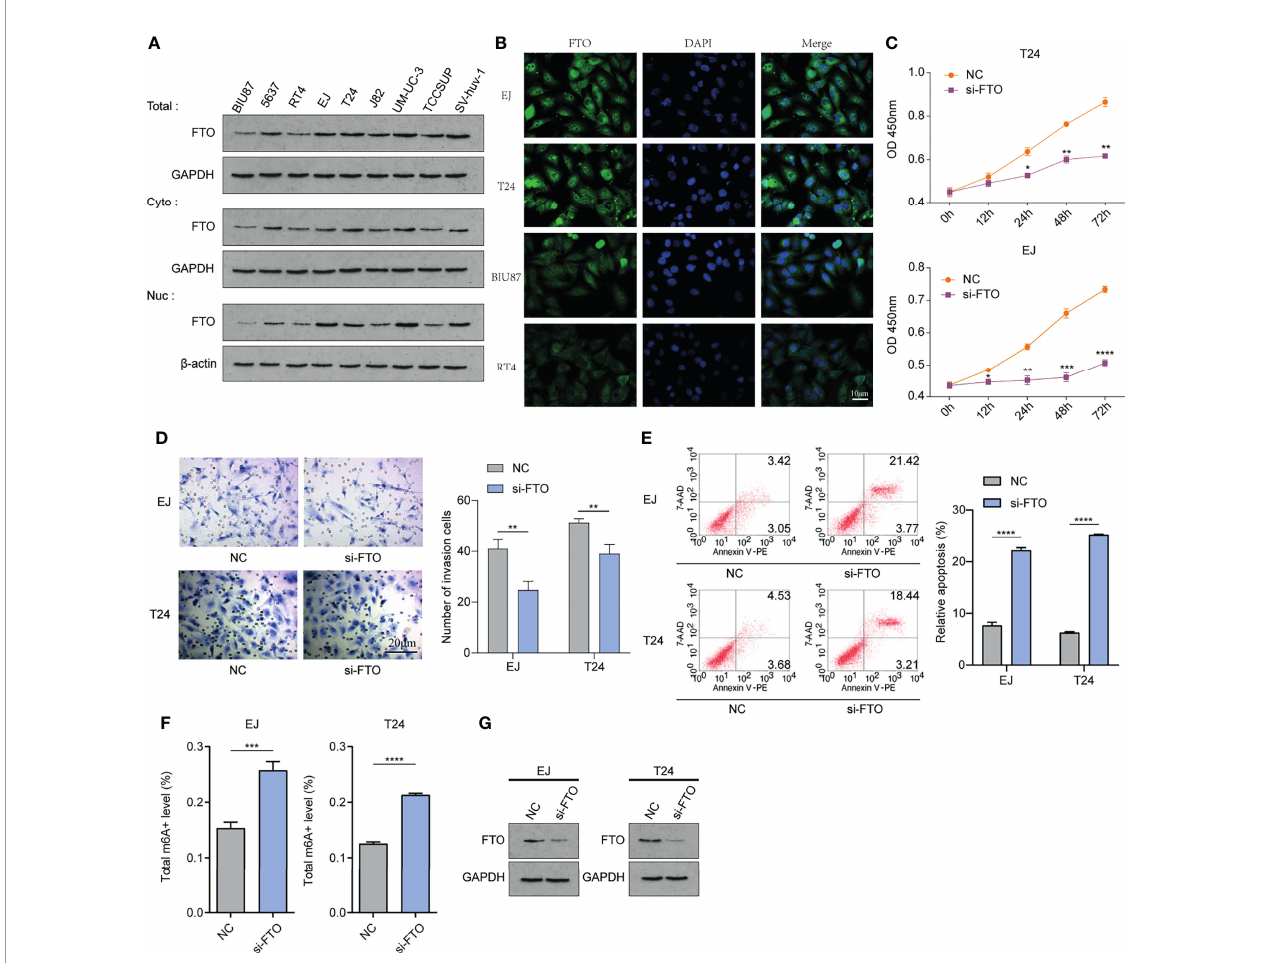
FIGURE 10 | FTO could be involved in the occurrence and development of bladder cancer in vitro. (A) Western Blot method to detect nuclear, cytoplasmic, and overall expression levels in BIU87 cells, 5637 cells, T24 cells, EJ cells, RT4 cells, J82 cells, UM-UC-3 cells, TCCSUP cells, and human bladder epithelial immortalized SV-huv-1 cells. (B) IF immuno fl uorescence method to detect the cellular localization of FTO protein. (C) Cell Counting Kit-8(CCK-8) to detect the proliferation level of each group of cells. (D) Transwell method to observe the invasion level of each group of cells. (E) Flow cytometry method to detect apoptosis in each group. (F) Detection of m 6 A enzyme activity level in each group. (G) Western Blot method to detect the FTO expression level after siRNA knockdown. The histogram data for each group is the average of three independent replicates; bars represent mean ± SD; *P < 0.05, **P < 0.01, ***P < 0.001, ****P <